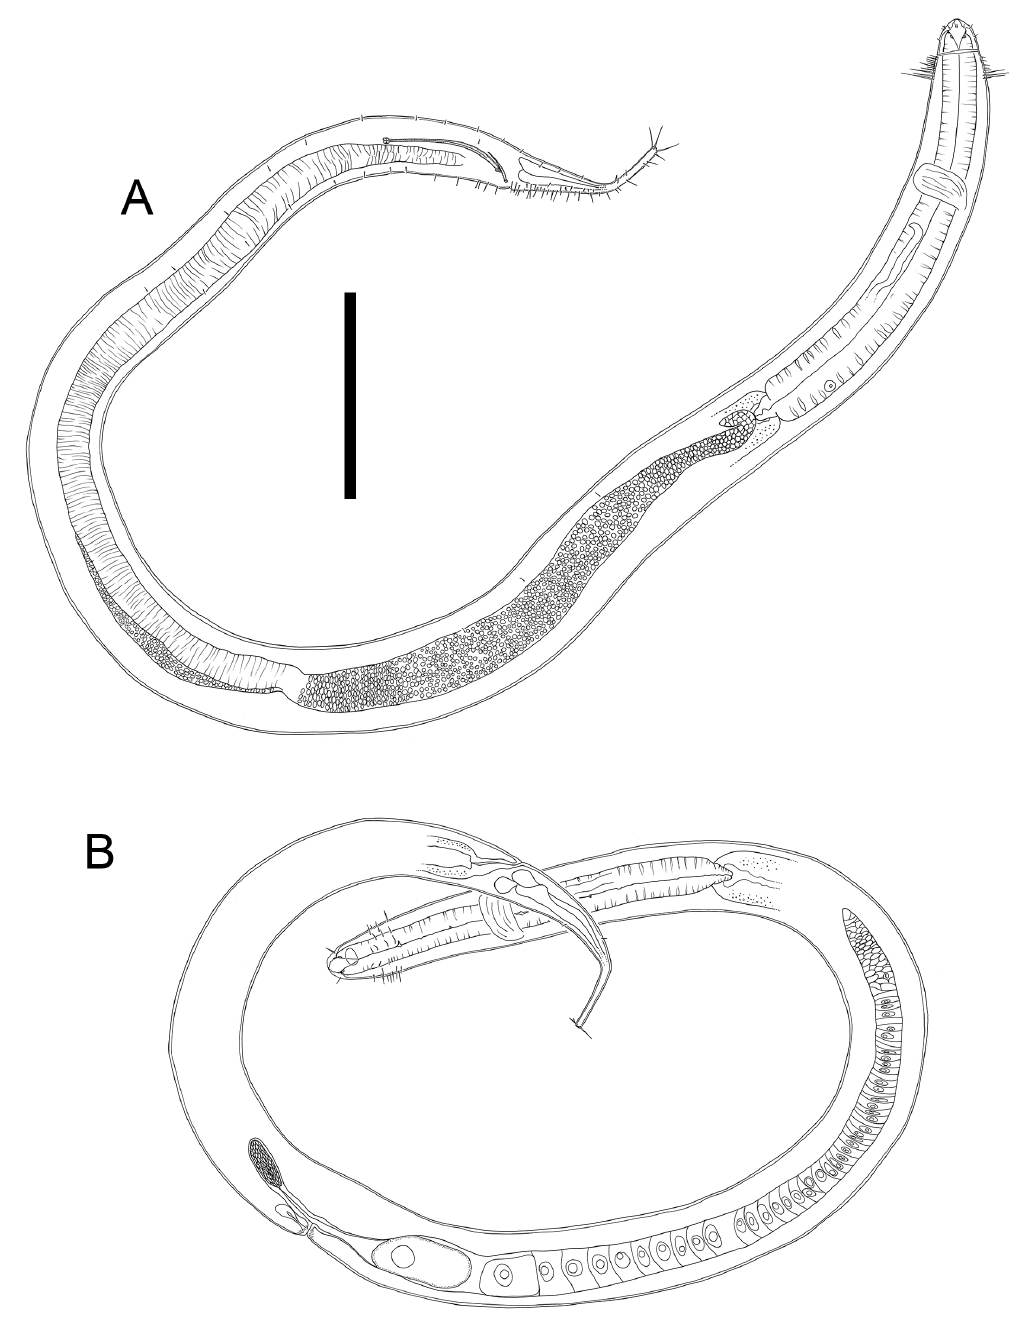
Fig. 11. Deraionema barbatum gen. et sp. nov. A . Entire male, holotype (NIWA154914). B . Entire female, paratype (NIWA154917). Scale bar = 250